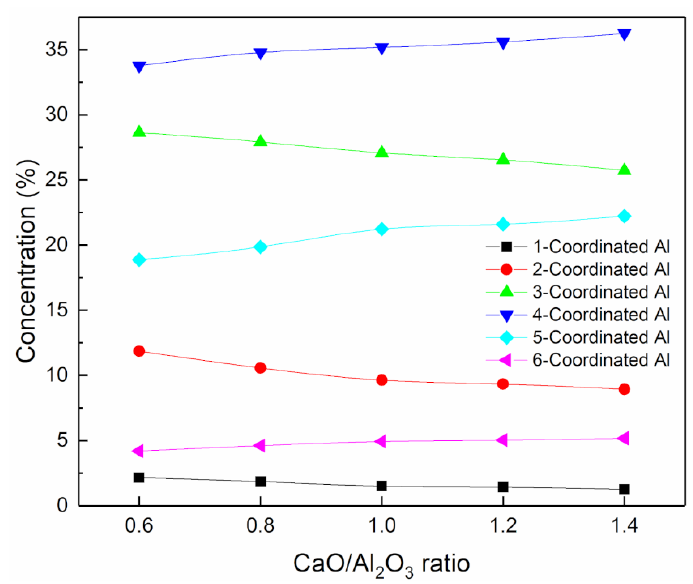
Figure 7. Variation of n-coordinated Al with different CaO/Al 2 O 3